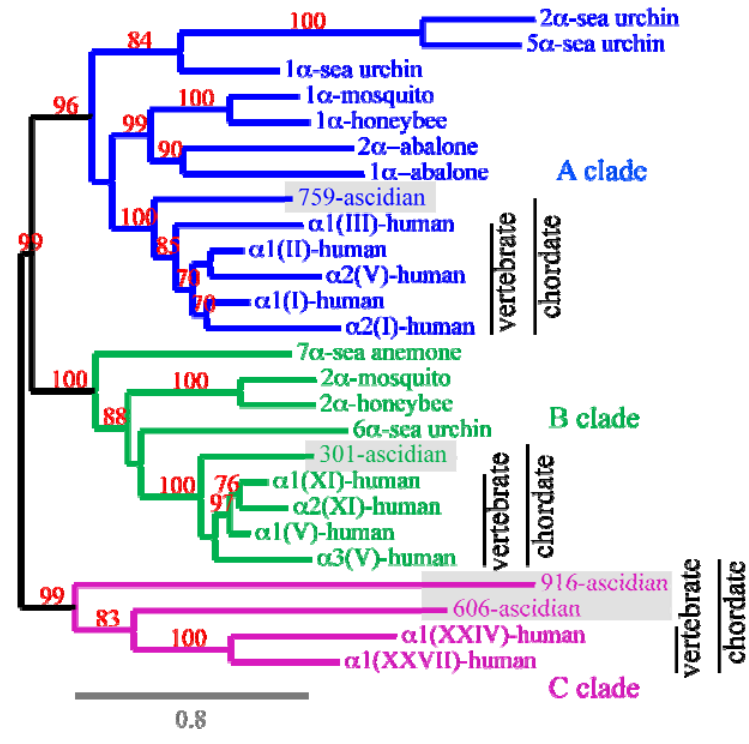
Figure 5. Phylogenetic analysis of some metazoan fibrillar collagen chains. This unrooted tree was modified from a previous study [30]. The illustration was drawn using the TreeDyn program [49]. Gray boxes indicate the ascidian fibrillar collagen